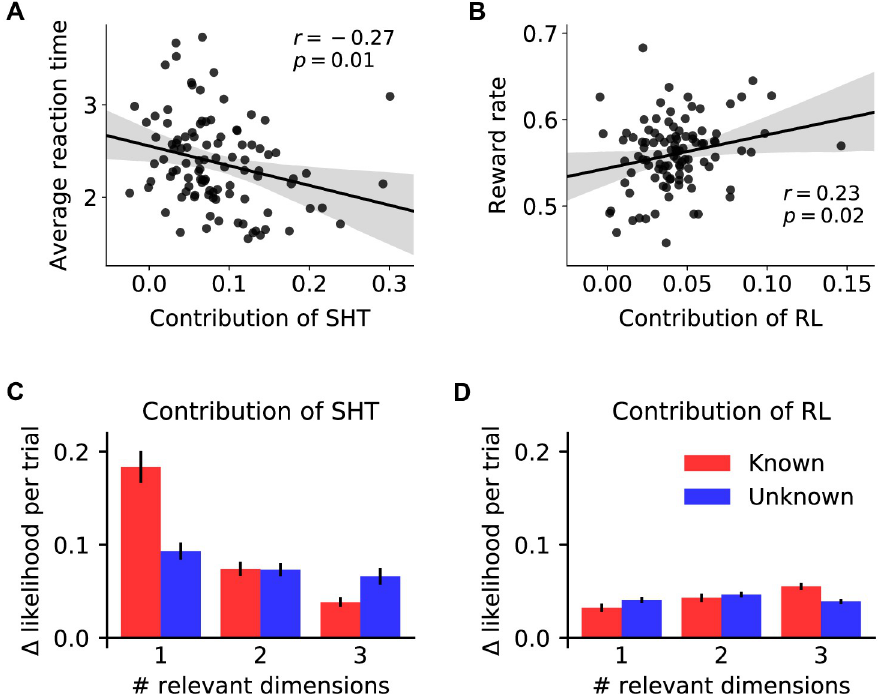
Fig 5. Strategic balance of two learning mechanisms. (A) The contribution of serial hypothesis testing (SHT) was inversely correlated with reaction time such that participants who responded faster used SHT to a greater extent. (B) The contribution of reinforcement learning (RL) was correlated with average reward rate: participants for whom adding the RL component improved the model fit to a greater extent earned more rewards on the task, on average. Each dot represents one participant. (C, D) Contribution of RL and SHT for each game type. The contribution of each component was measured as the difference in likelihood per trial between the hybrid value-based SHT model and the other component model (SHT: the feature RL with decay model; RL: the random-switch SHT model). Error bars represent ± 1 s.e.m. across participants.